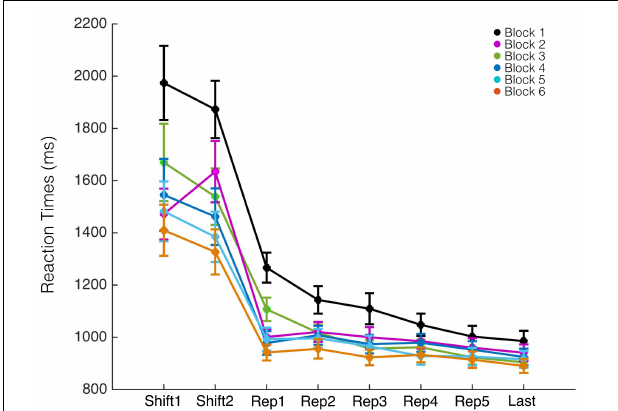
FIGURE 2 | Reaction times according to experimental block presentation. The first block (in black) showed longer RTs for switch trials (shift1, shift2) and repetition trials (rep1–rep3). Error bars show the standard error of the mean.